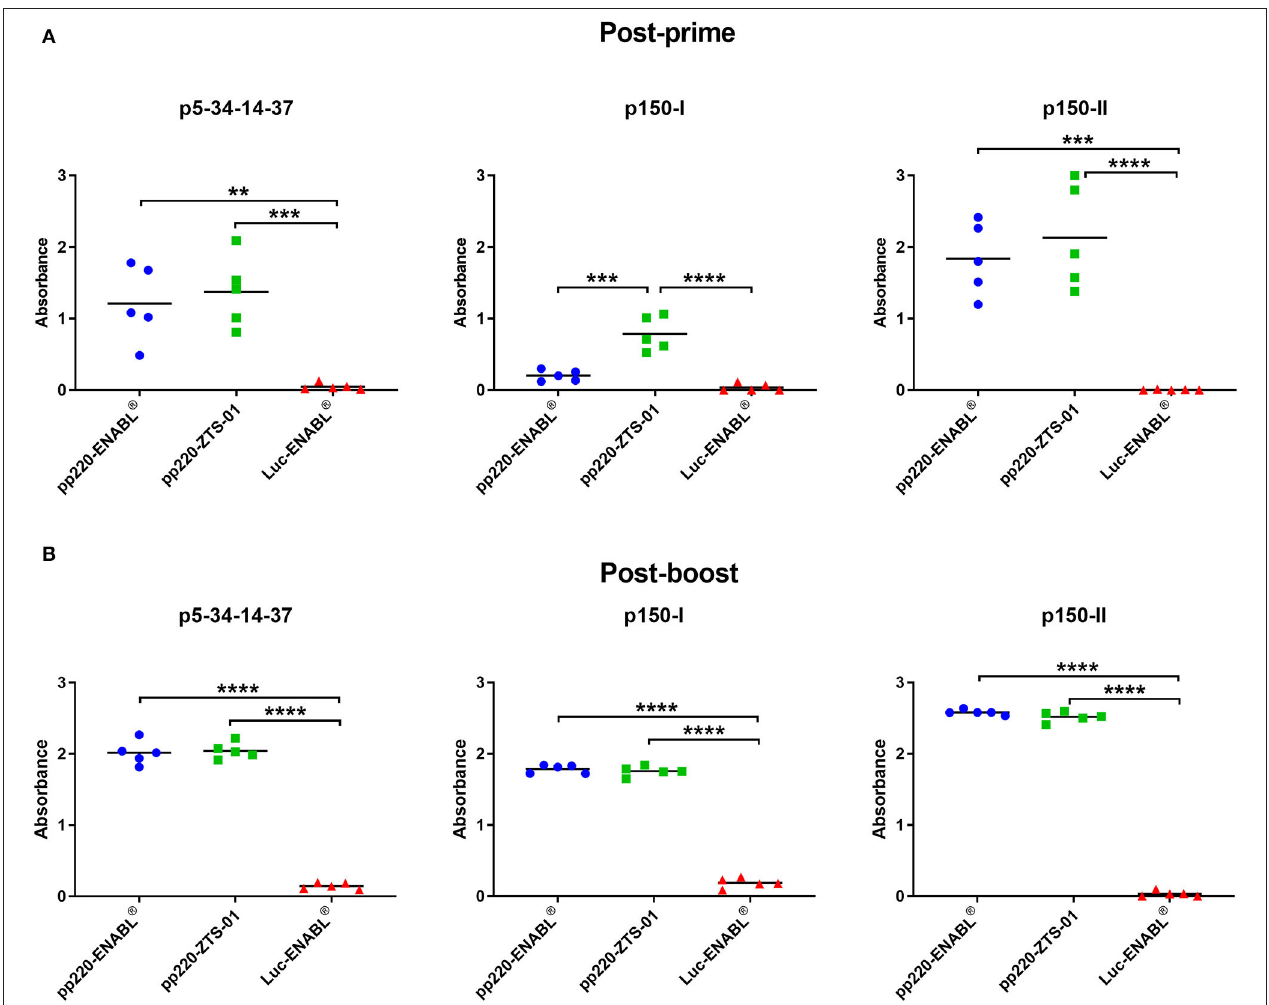
FIGURE 4 | Antibody responses against pp220 antigens. IgG responses against p5-34-14-37, p150-I and p150-II in (A) week 4 post-prime sera; and (B) week 1 post-boost sera were evaluated by ELISA. Mean responses for the groups are denoted by bars and statistically significant differences between groups is denoted by asterisks (** p < 0.01, *** p < 0.001 and **** p < 0.0001).